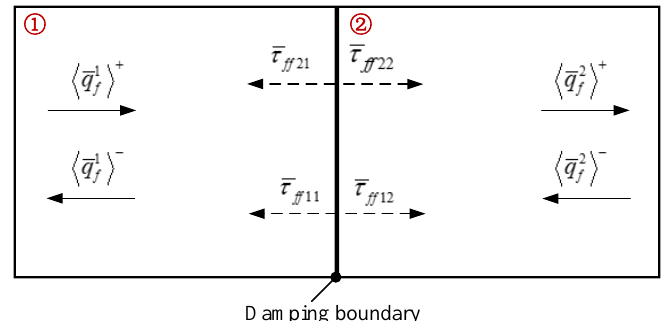
Figure 3. Power transmission relation between subdomains with and without FLD treatment.